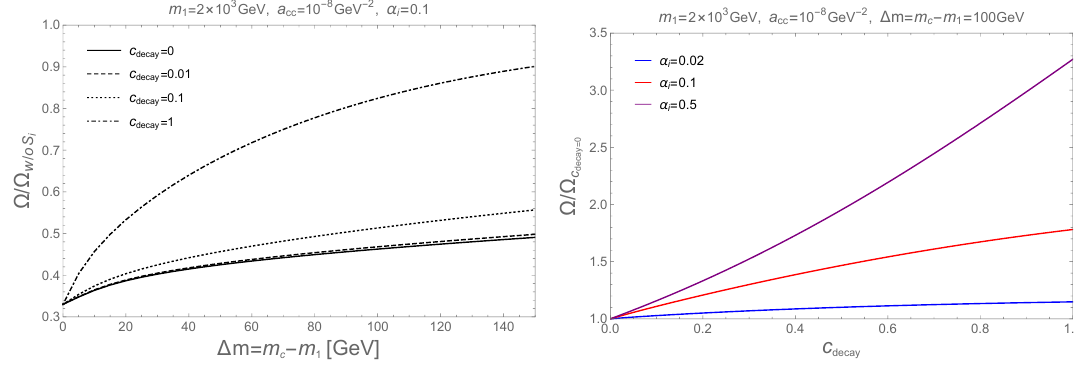
Figure 4 . Left panel: the ratio of DM relic densities with and without the ISS effect, as a function of the mass difference between the coannihilator and the DM particle, for α i = 0 . 1 . The solid, dashed, dotted and dash-dotted lines are for c decay = 0 , 0 . 01 , 0 . 1 and 1 , respectively. Right panel: the ratio of DM relic densities with and without considering the decay of the coannihilator, as a function of the decay parameter c decay , for ∆ m = 100 GeV . The blue, red and purple lines are for α i = 0 . 02 , 0 . 1 and 0 . 5 , respectively. For both panels, we use g 1 = g c = 2 , m 1 = 2 × 10 3 GeV and a cc = 10 − 8 GeV − 2